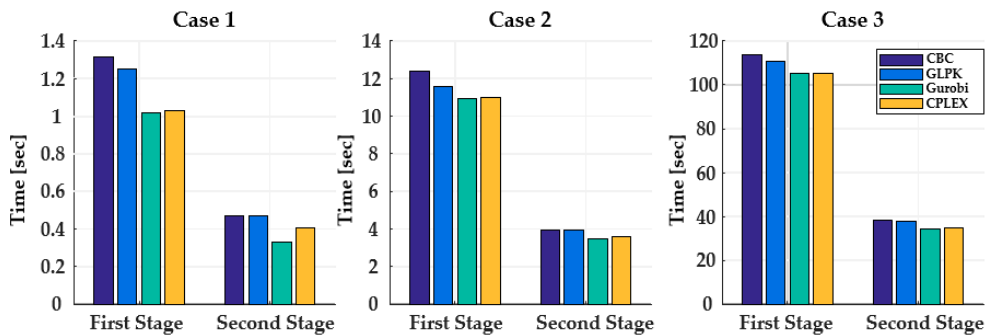
Figure 10. Comparison of the total computation times with modeling package PuLP.